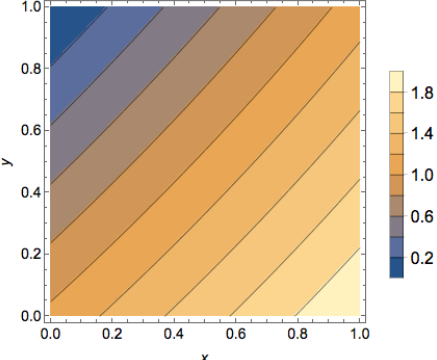
Figure 8. Social welfare for all states in Example 2. A point ( x , y ) represents a mixed strategy profile where the first agent chooses its first strategy with probability x and the second agent chooses its first strategy with probability y . The color of the point ( x , y ) corresponds to the social welfare of that mixed strategy profile with states of higher social welfare corresponding to lighter shades. The optimal state is ( 1,0 ) , whereas the worst state is ( 0,1 )